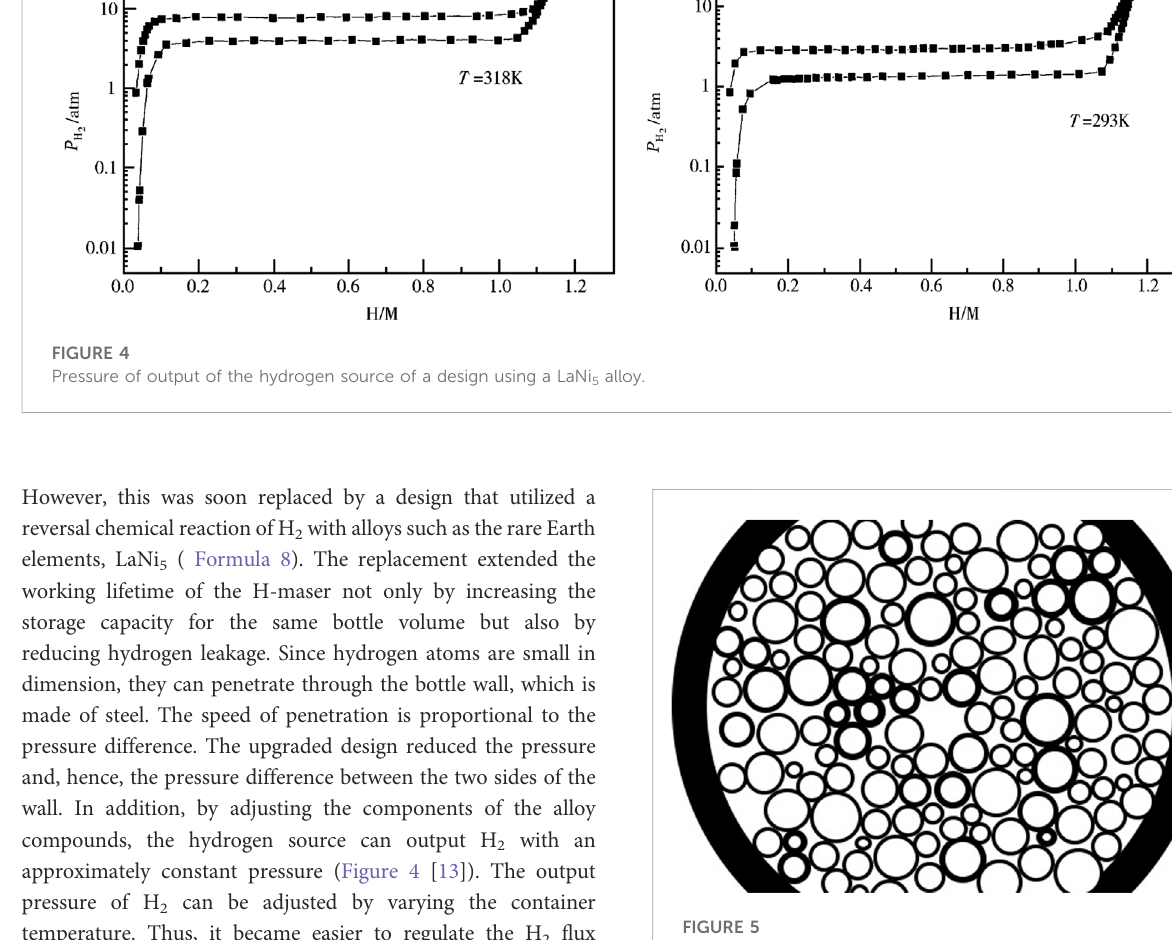
FIGURE 5 Schematic of a multichannel